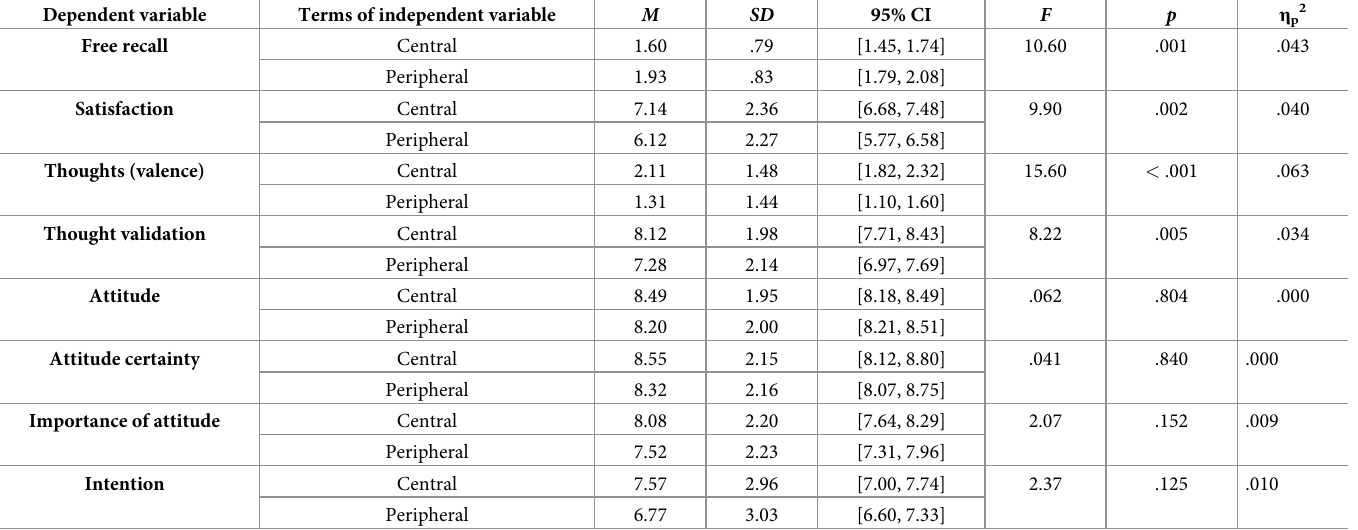
Table 2. Effects of structural status of social representations (summary of ANOVA